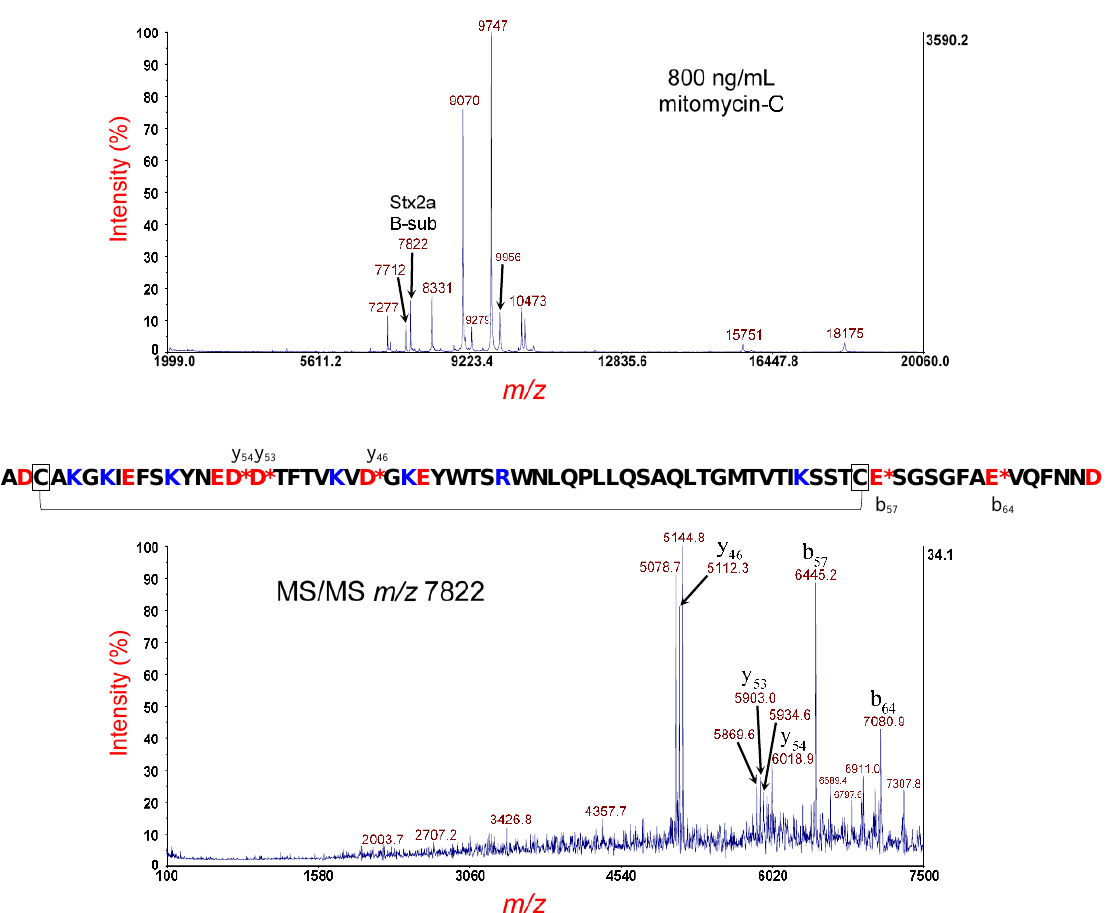
Figure 3. Top panel: MS analysis of E. coli O145:H28 strain RM12367-C1 cultured overnight on LBA supplemented with 800 ng / mL of mitomycin-C. The putative disulfide-bond-intact B-subunit of Stx2a is indicated. Bottom panel: MS / MS analysis of the putative B-subunit at m / z 7822 in the top panel. Fragment ions are indicated by their m / z and b- or y-type designations. The sequence of the Stx2a B-subunit is shown. A red asterisk indicates sites of polypeptide backbone cleavage that generate the corresponding fragment ions shown above (y-type) or below (b-type) the sequence. Acidic residues are highlighted in red and basic residues in blue. Cysteine residues are boxed, and a connector line symbolizes the intramolecular disulfide bond.